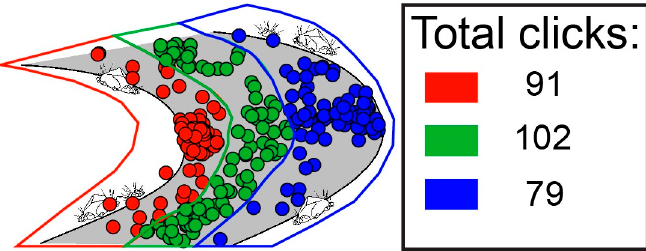
Figure 8. Polygons and student clicks in response to the prompt, “Click in the river where you would find the fastest moving water”. The correct region, labeled in blue ( n = 79), is the outside of the river bend. The region labeled in red ( n = 91) and green ( n = 102) will have relatively lower velocity and erosion.